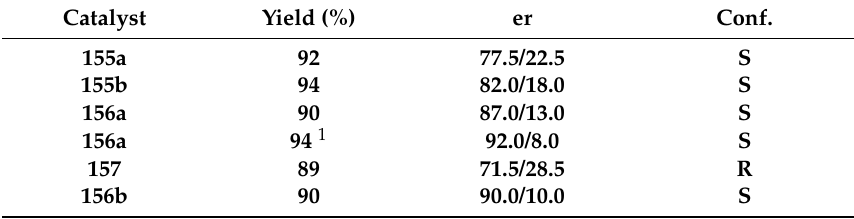
Table 10. Enantioselective aldol addition of trichlorosilyl enolate of methyl acetate to acetophenone. Catalyst Yield (%) er Conf. 155a 92 77.5/22.5 S 155b 94 82.0/18.0 156a 90 87.0/13.0